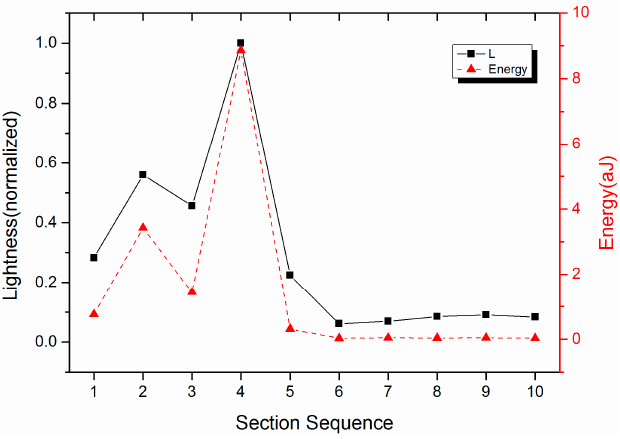
Figure 5. Comparison of waveforms between parameters L and the energy of the UHF-B frequency spectrum.